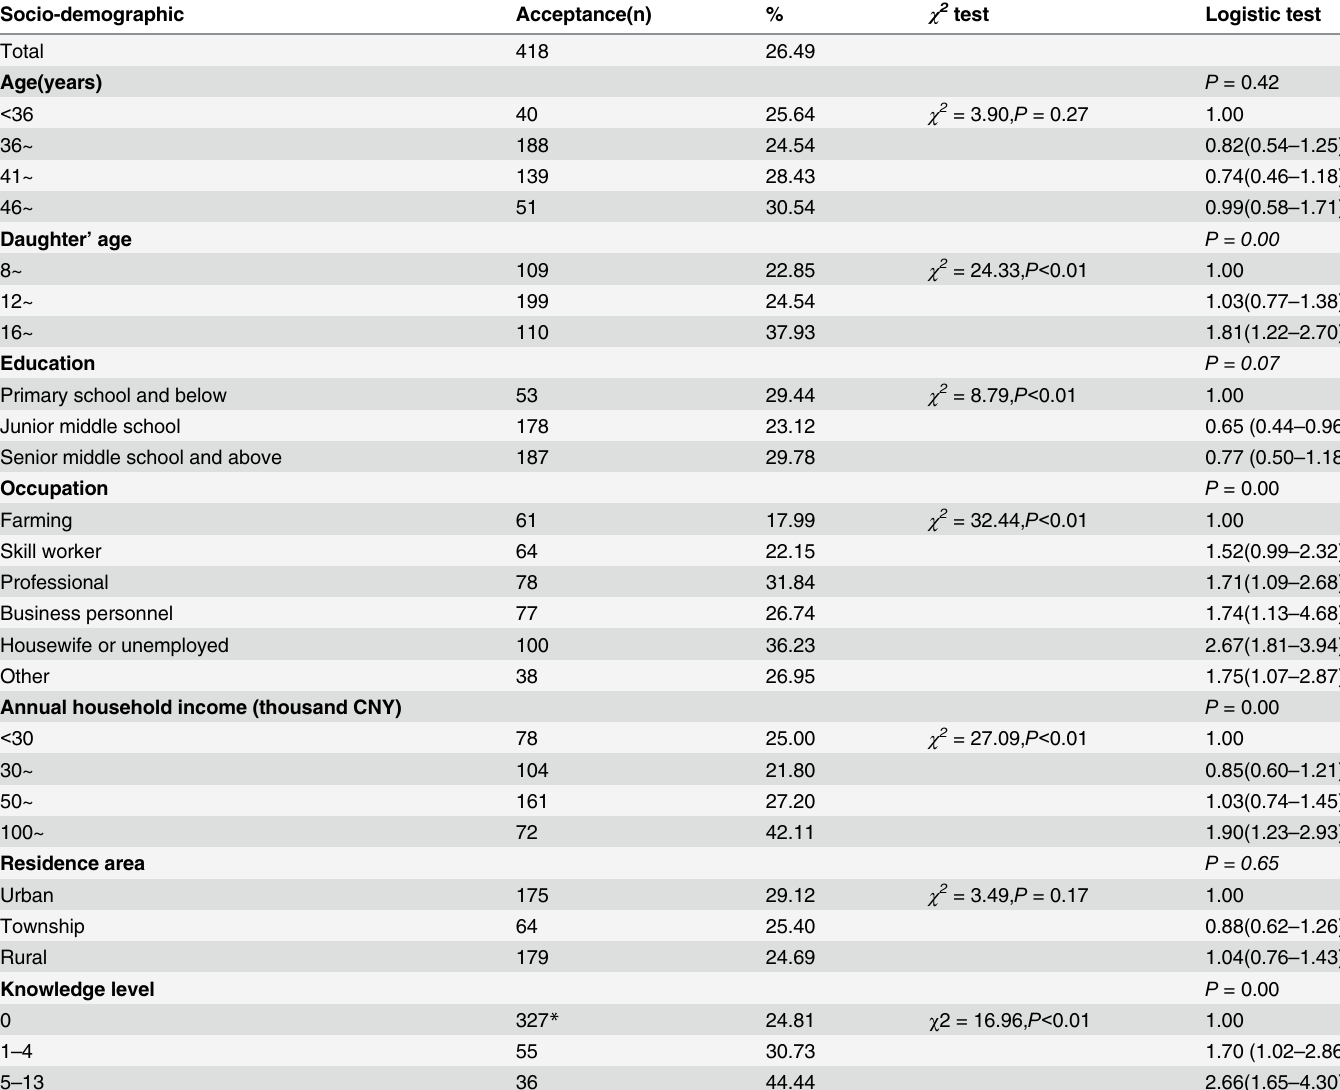
Table 5. The acceptability of HPV vaccination and logistic regression